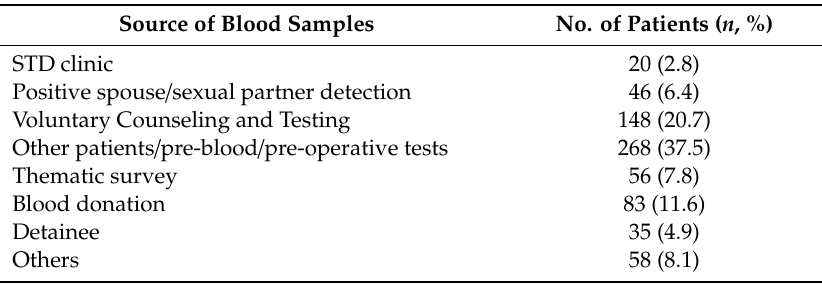
Table 3. Sample source in 714 HIV-infected patients who completed CD4 + T cell test within one year of